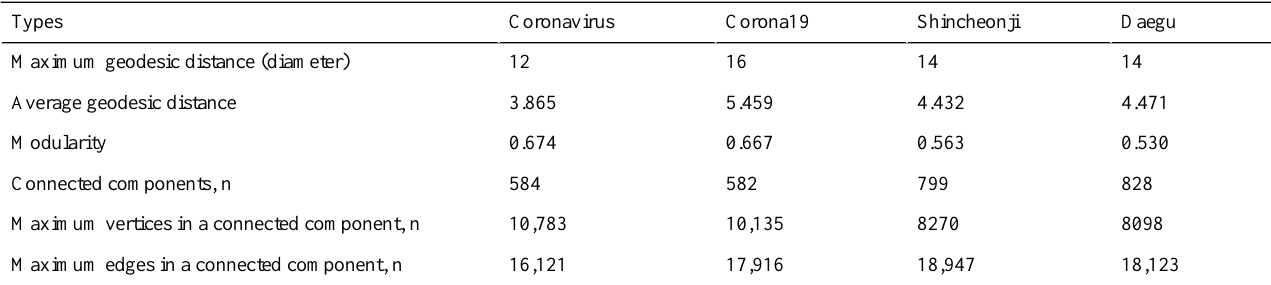
Table 2. Comparing coronavirus disease network properties on